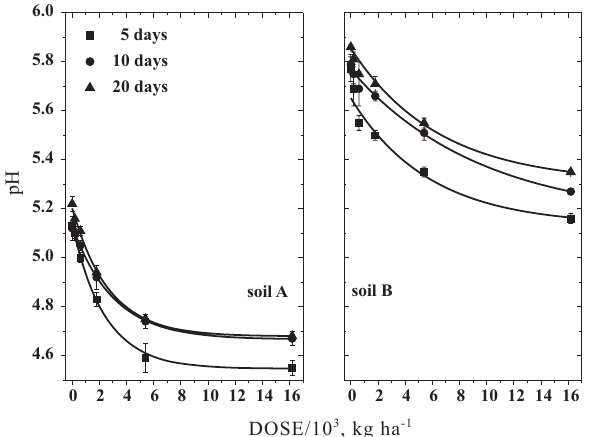
Figure 1. Evolution of soil acidity under increasing doses of solid residue in soils A and B. Table 3 shows the fitted parameter values according to the algebraic model adjusted for pH